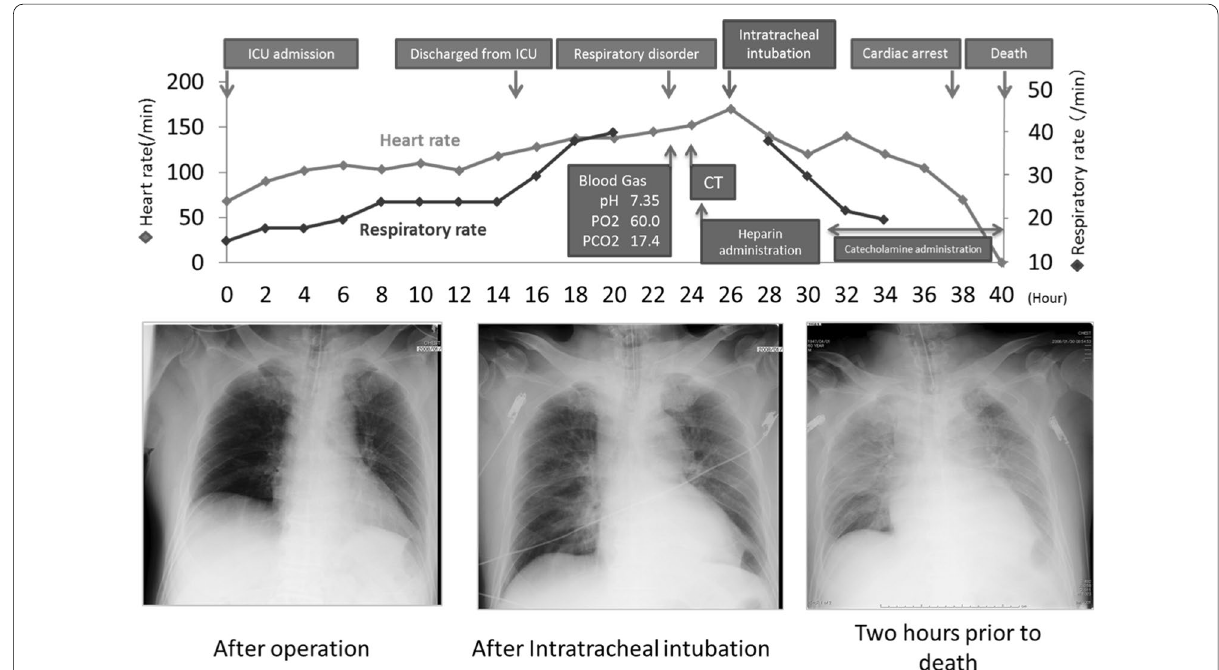
Fig. 2 Postoperative course. The respiratory failure progressed rapidly, and the patient was diseased 14 h after intratracheal